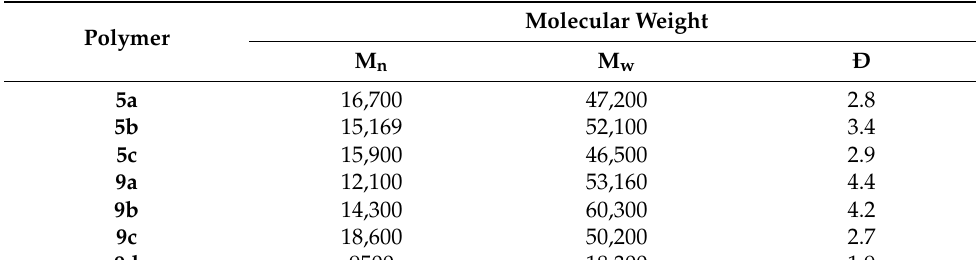
Table 2. Molecular weight M n , M w , and Ð of the synthesis novolac polymers 5a – c and 9a – d . (Results are expressed as rounded to the third significant number).